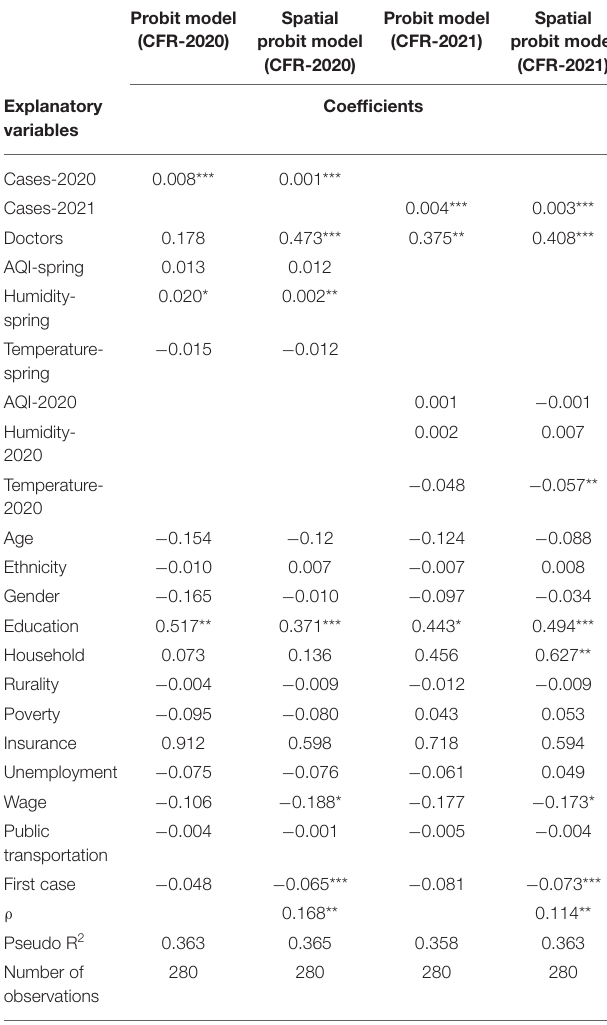
TABLE 2 | Descriptive statistical analysis. TABLE 3 | First part: Regression estimates of the probit